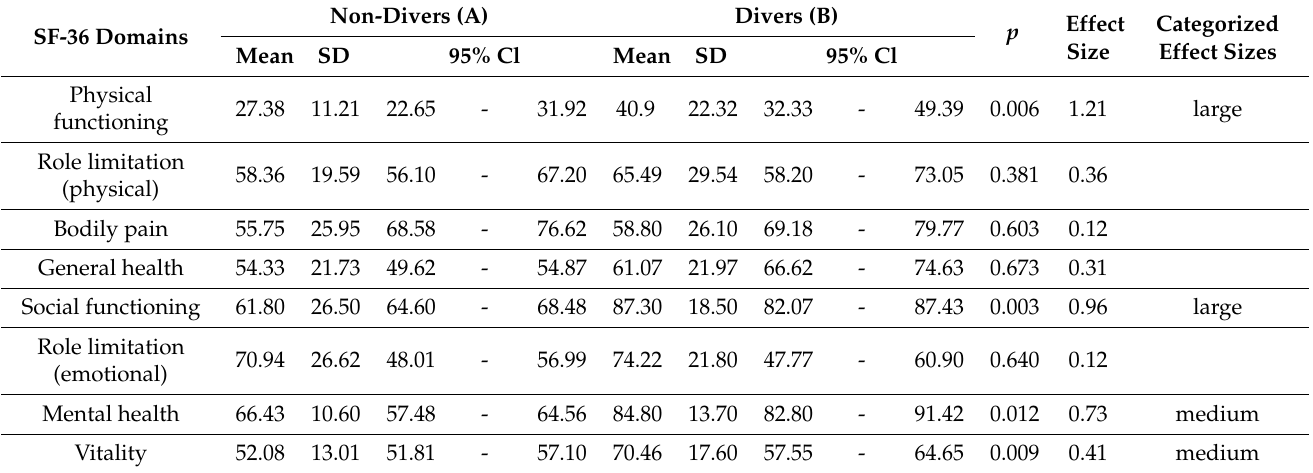
Table 2. Scores in eight domains of SF-36 provided by diving and non-diving people with